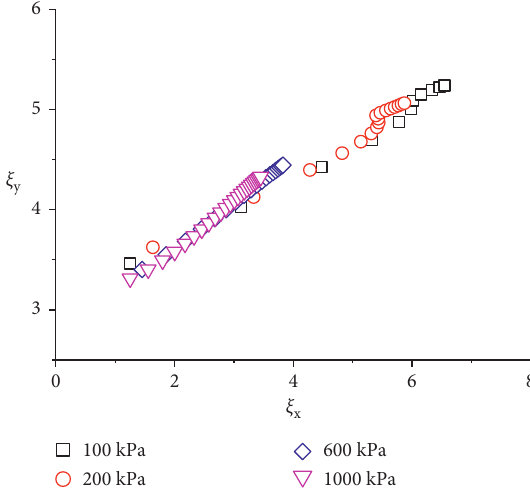
Figure 5: CT tests of limestone rockfill materials